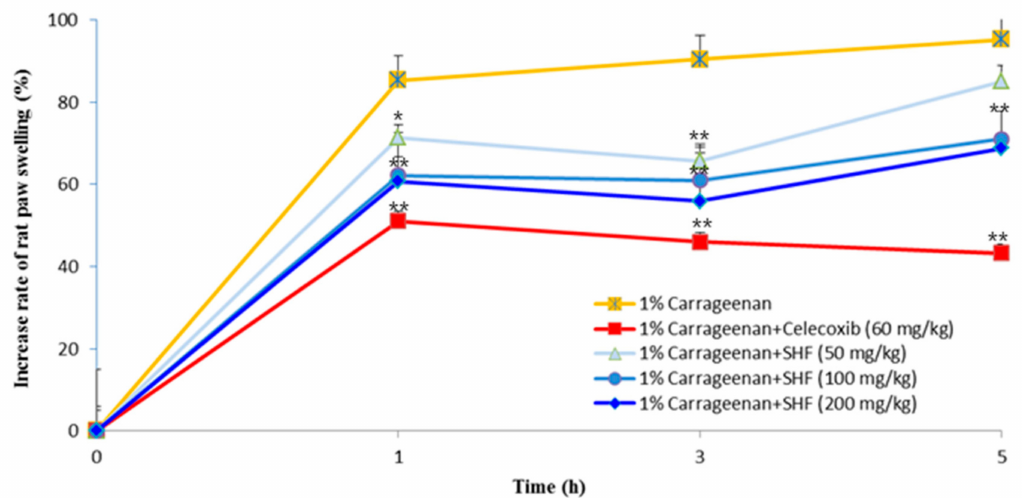
Figure 8. Effect of the Stauntonia hexaphylla fruit (SHF) extract on carrageenan-induced rat paw edema. SHF extract was administered in a quantity of 50, 100 and 200 mg/kg for 3 days before the carrageenan injection (1% carrageenan suspended in saline), whereas celecoxib (60 mg/kg, positive control, p.o.) was administered 1 h before the carrageenan injection. Subsequently, 1 h after treatment, 1% carrageenan was injected into the right hind paw of each rat. The left paw was used as a control (0.1 mL saline injected). Edema was measured at 0 h, 1 h, 3 h and 5 h after injection of carrageenan